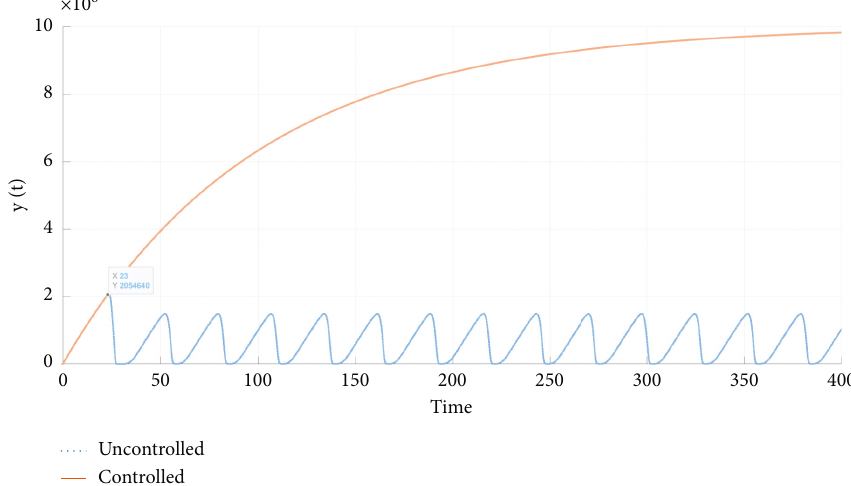
Figure 4: Comparison of controlled and uncontrolled susceptible cell populations.